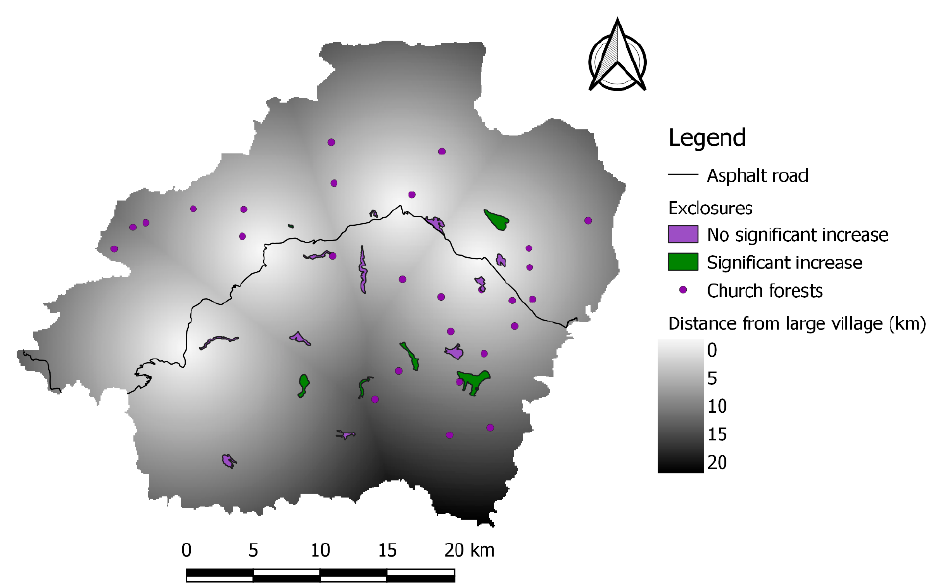
Figure A5. Distance from the four largest villages within the Degua Tembien district, together with the location of the 17 exclosures and 25 church forests included in the analysis.